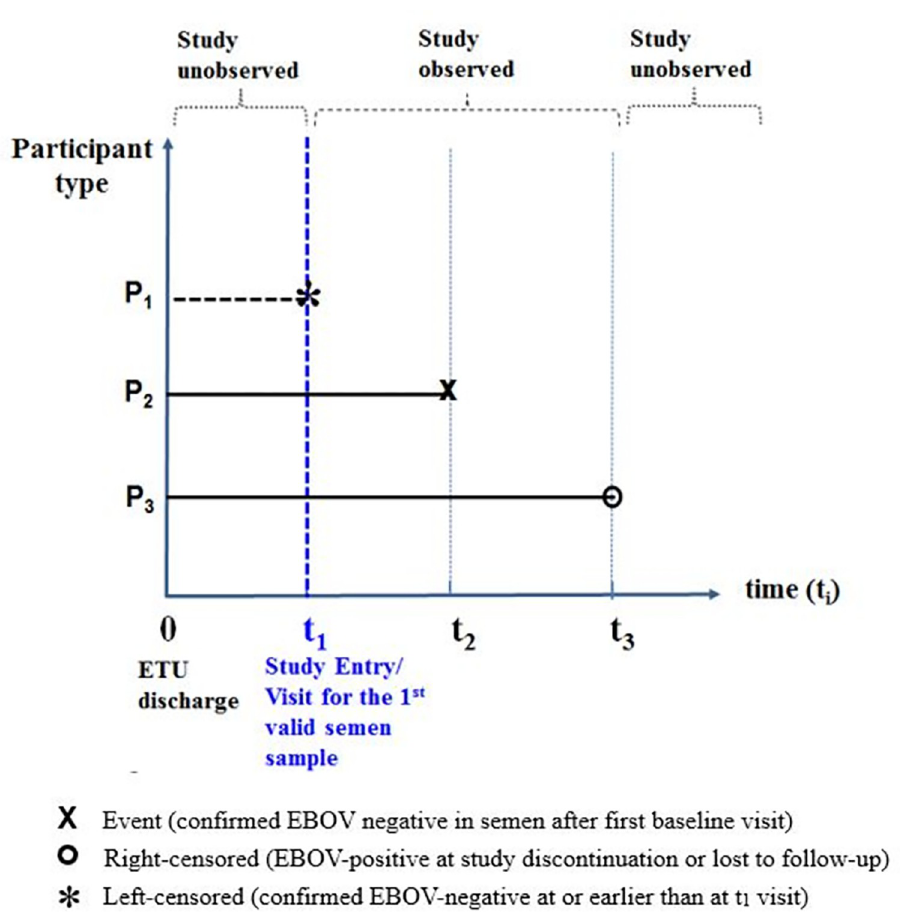
Fig 1. Study participants time to confirmed negative Ebola virus RNA in semen, by type of censoring experienced.